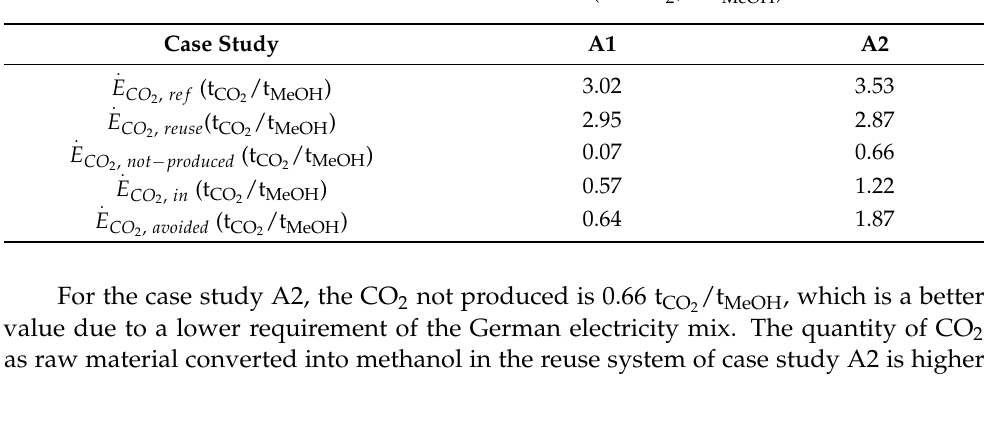
Table 11. Main metrics related to carbon dioxide emissions (tonCO 2 /ton MeOH